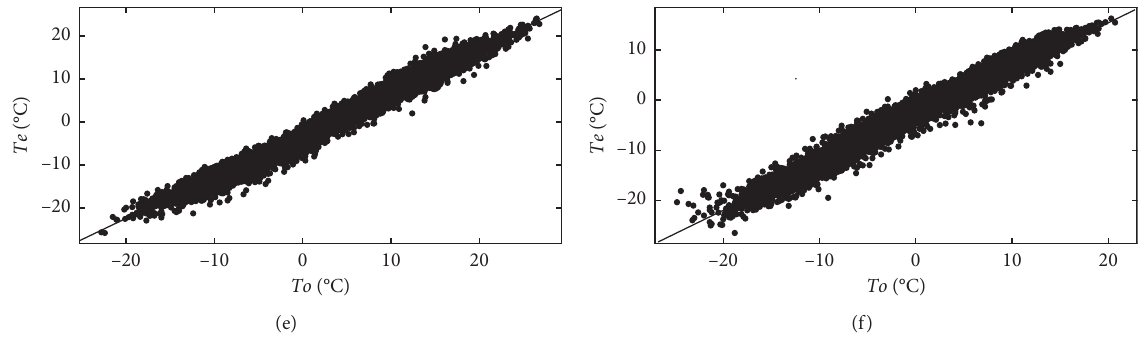
Figure 2: Scatter plots of comparison of ERA-Interim daily temperature with observations at station No. 6, No. 11, No. 14, No. 15, No. 19, and No. 20 in 1979–2017. The solid line is 1 :1 line. (a) Station No. 6. (b) Station No.11. (c) Station No.14. (d) Station No.15. (e) Station No. 19. (f) Station No.